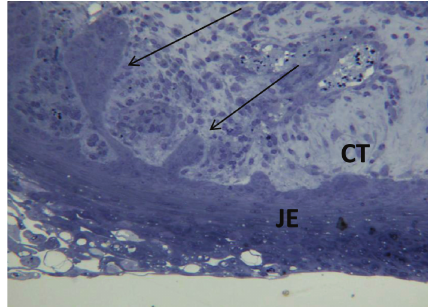
Figure 3: Primary JE culture treated with A. actinomycetemcomitans LPS shows migration of the epithelium into CT (arrows).